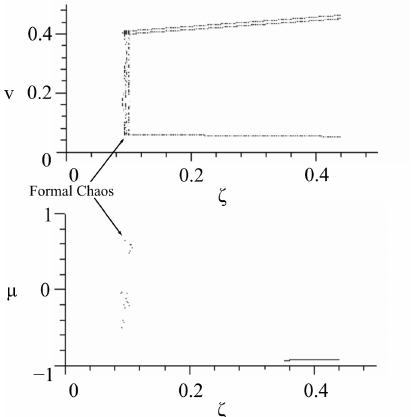
Figure 13. Bifurcation diagram with ζ parameter.